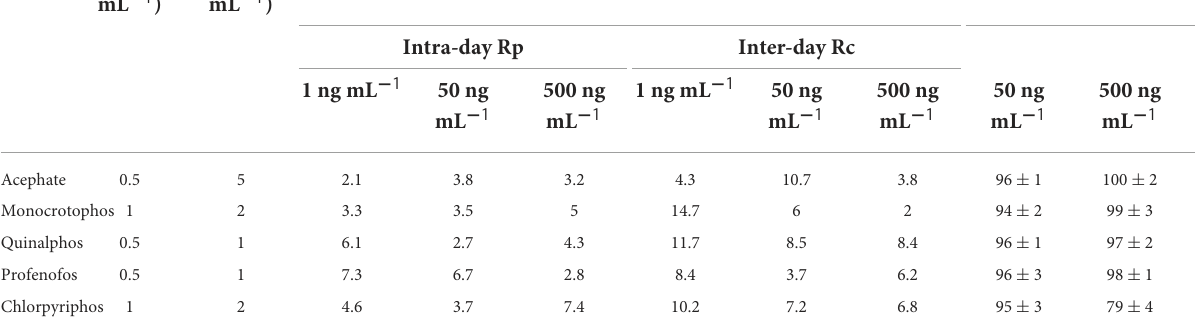
TABLE 3 Performance parameters of the LC-MS/MS method for the determination of pesticide residues in hand washings. Analyte LOD (ng